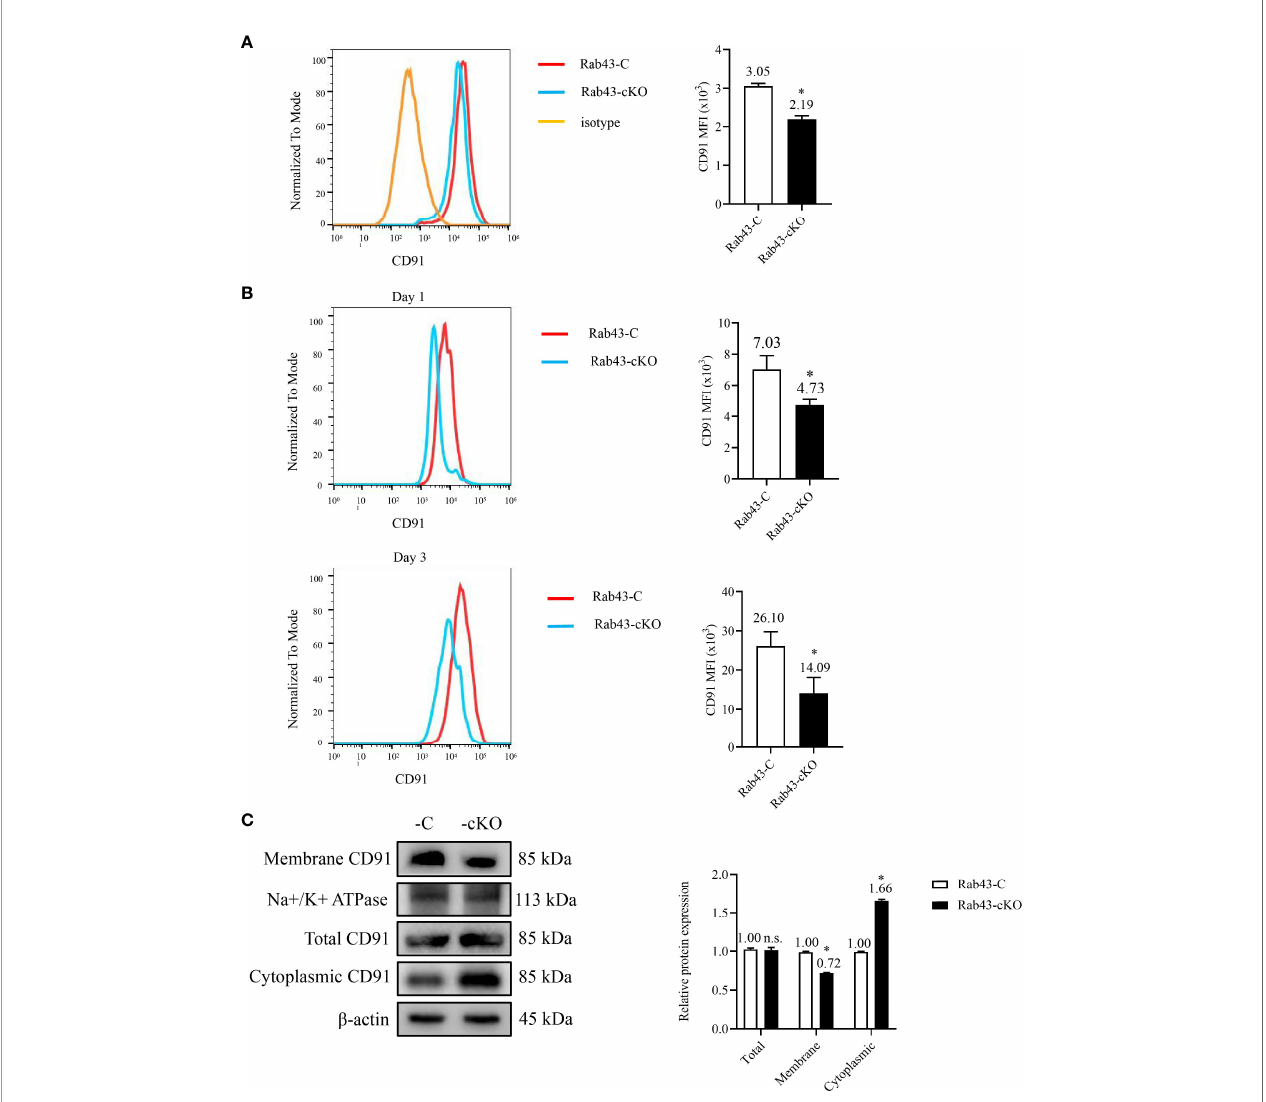
FIGURE 5 | Effects of Rab43 knockout on the cell surface transport of endogenous CD91. (A) The CD91 proteins on the cell surface were analyzed using fl ow cytometry. The bone marrow-derived macrophages (BMDMs) were isolated from Rab43-C and Rab43-cKO mice. * P < 0.05 versus the Rab43-C group. (B) The CD91 levels on the cell surface of BALF samples. The Rab43-C and Rab43-cKO mice were treated with LPS for 1 (upper panel) and 3 days (lower panel). The macrophages (F4/80 + CD11c + CD11b − ) in the BALF samples were also analyzed. * P < 0.05 versus the Rab43-C group. (C) The expression of total, cytoplasmic, and membrane CD91 in Rab43-C and Rab43-cKO BMDMs measured using western blot analyses. *P < 0.05 versus Rab43-C group. ns, not statistically signi fi